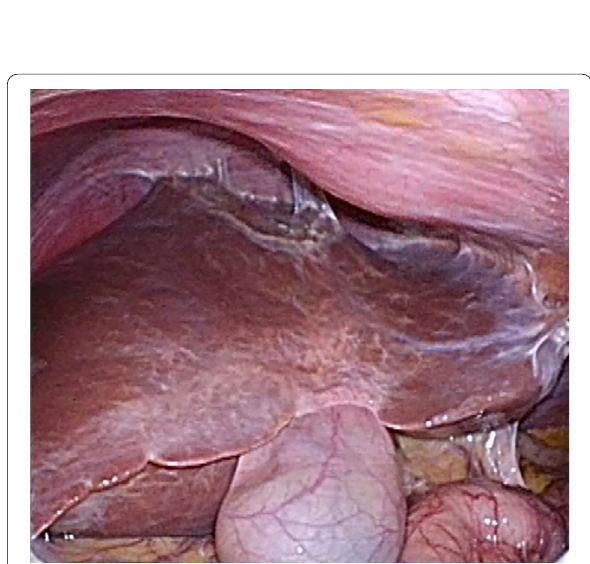
Fig. 5 Absence of severe adhesions in laparoscopic repeat